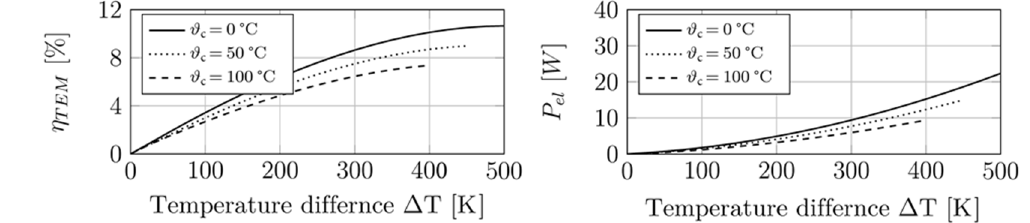
Figure A1. Performance diagram of the considered segmented high temperature module of the manufacturer LG Chem, from [3].